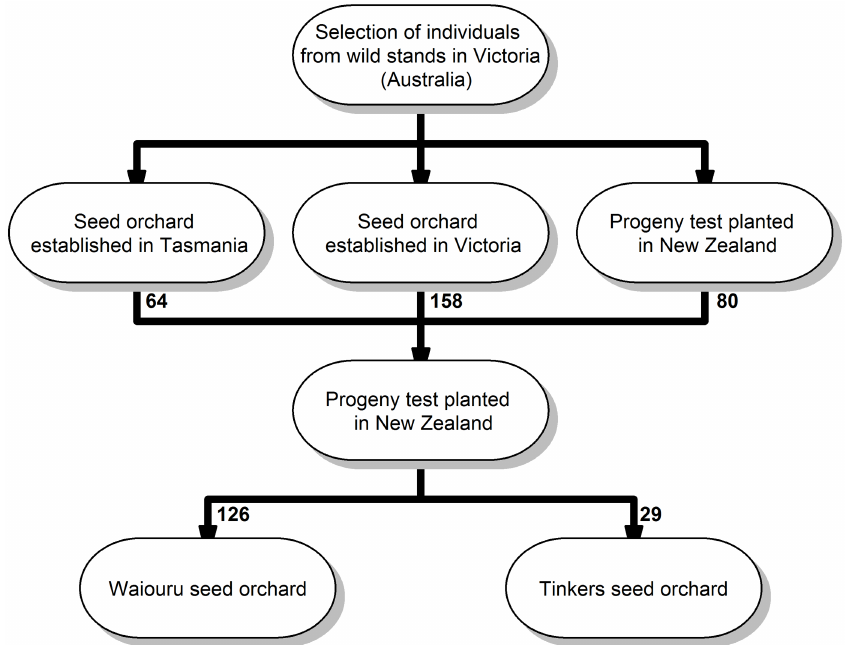
Fig 1. Breeding program history. History of the E. nitens breedingprogramestablished in New Zealand. The number of selectedparents are given in the arrows betweenthe different generations.